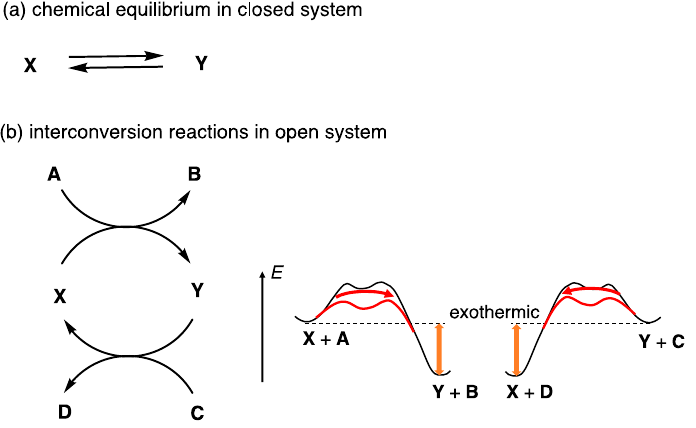
Figure 4. ( a ) Chemical equilibrium in a closed system between X and Y . ( b ) Interconversion reaction in an open system between X and Y , in which the relative thermodynamic stability of substrates and products is inverted and induces X + A → Y + B and Y + C → X + D reactions.